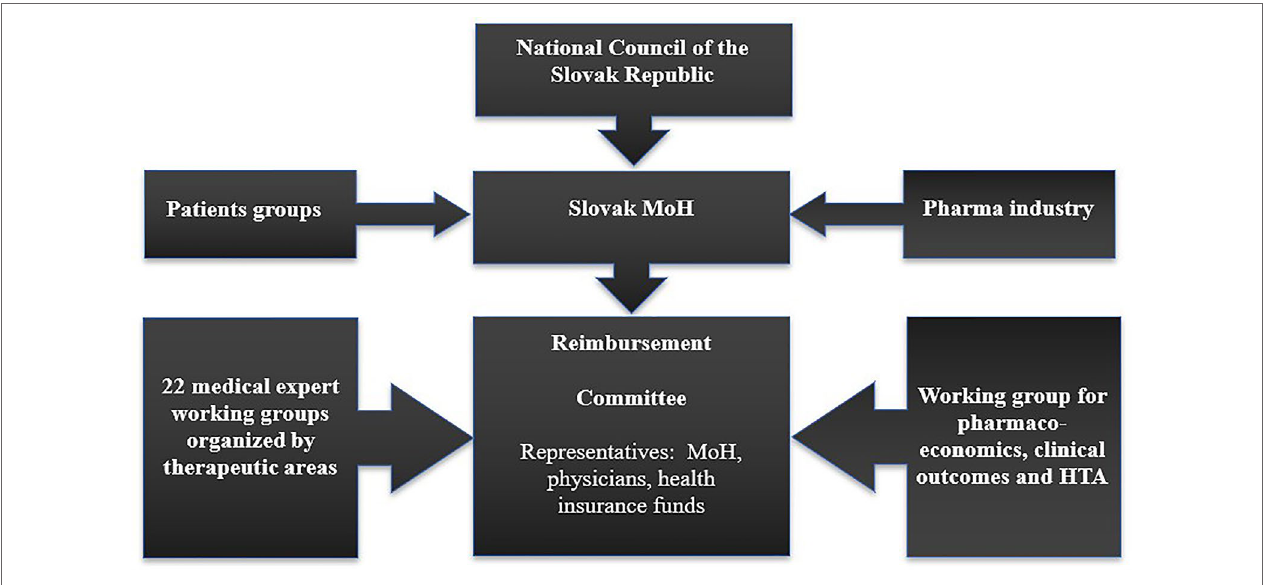
FIGURE 1 | Reimbursement process for pharmaceuticals in Slovakia.